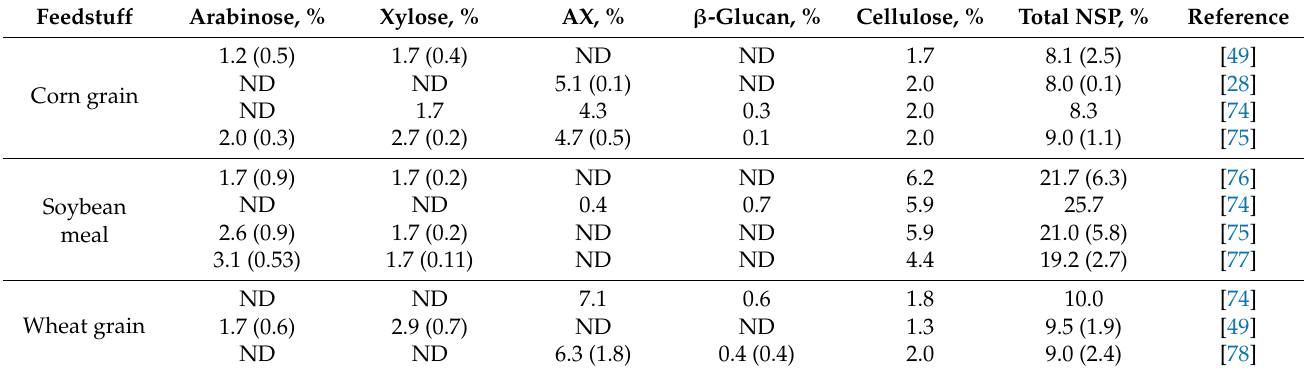
Table 1. Relative non-starch polysaccharides (NSPs) in feedstuff 1